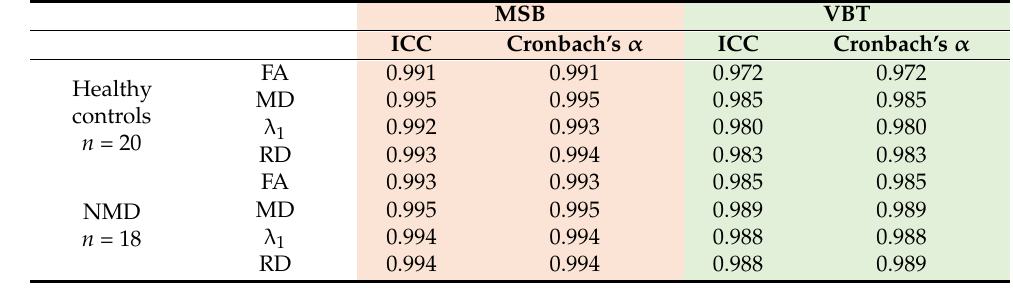
Table 2. Overview of intraclass correlation coefficient and Cronbach’s α for segmentation techniques; ICC = intraclass correlation coefficient, MSB = manual segmentation-based analysis, VBT = volume- based tractography, NMD = neuromuscular